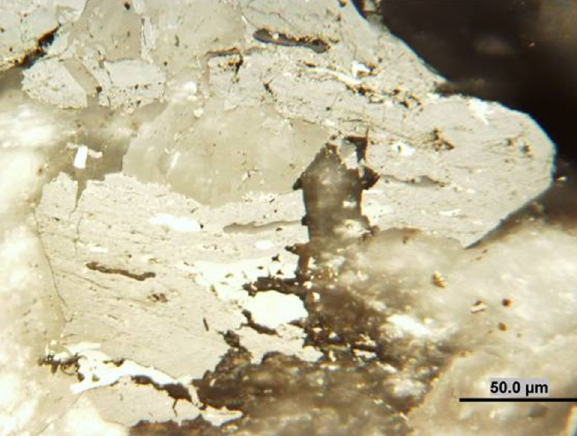
Fig. 9 Vitrinite with dispersed inertinite and liptinite macerals faulted by calcite